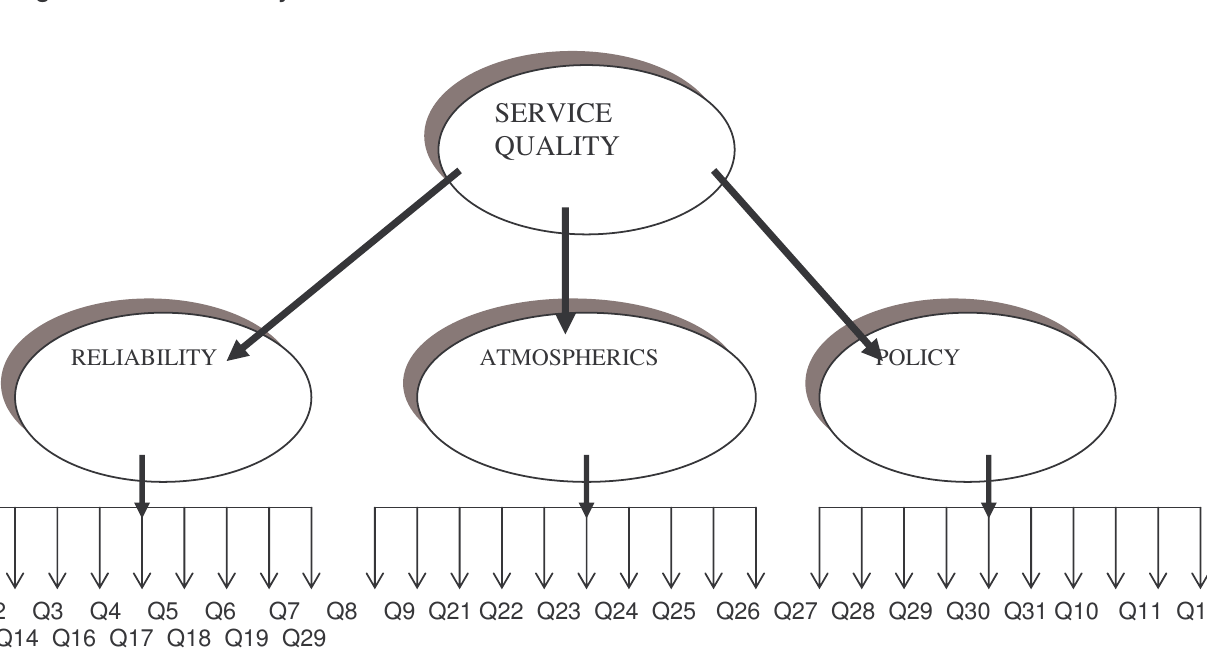
Figure 1: Service Quality